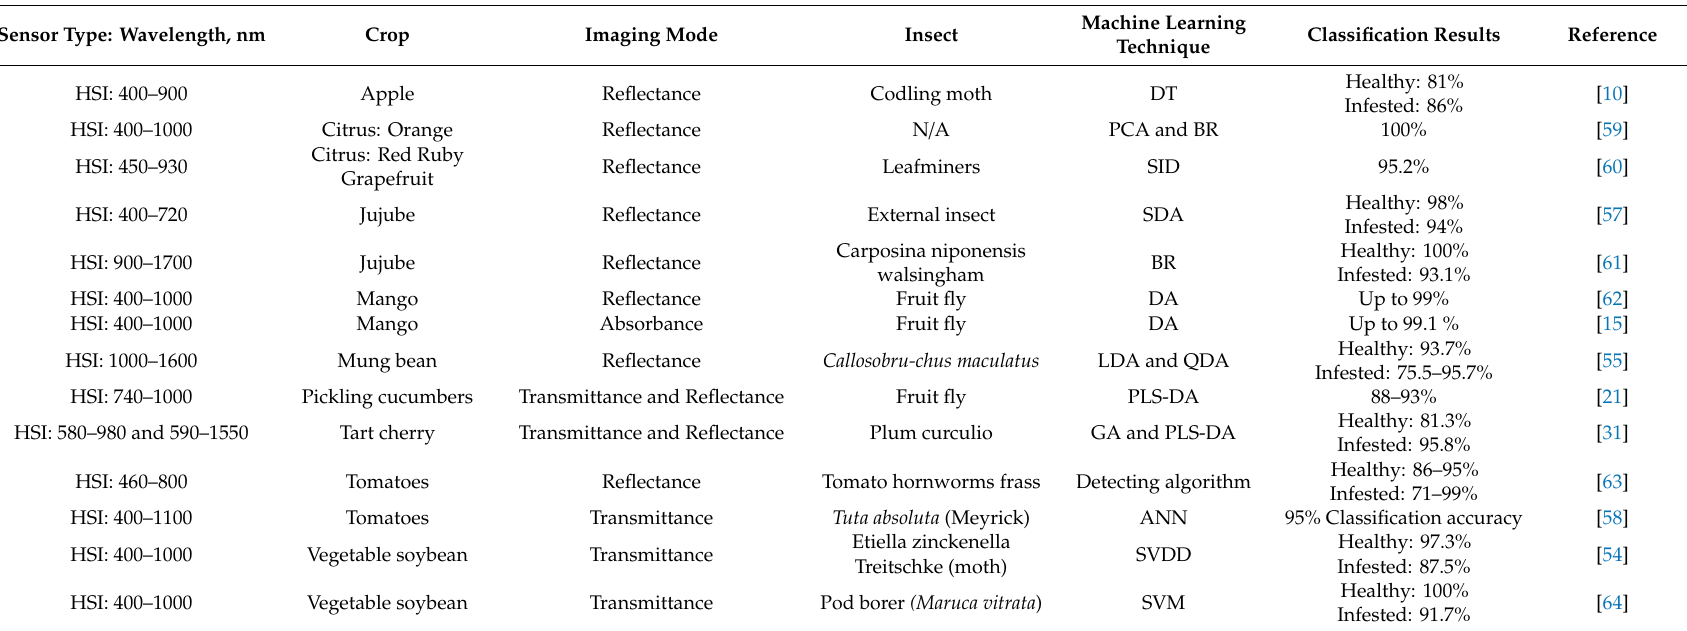
Table 2. Studies on insect infestations detection in fruits and vegetables using hyperspectral imaging systems